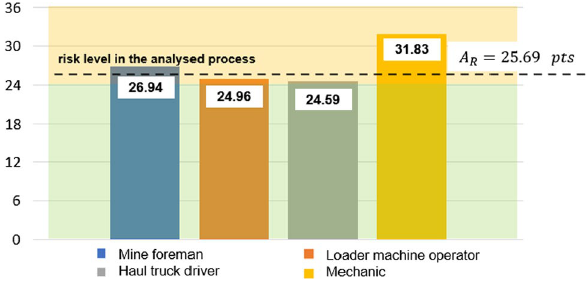
Fig. 8 The averaged risk level ( A R ) in terms of position and process